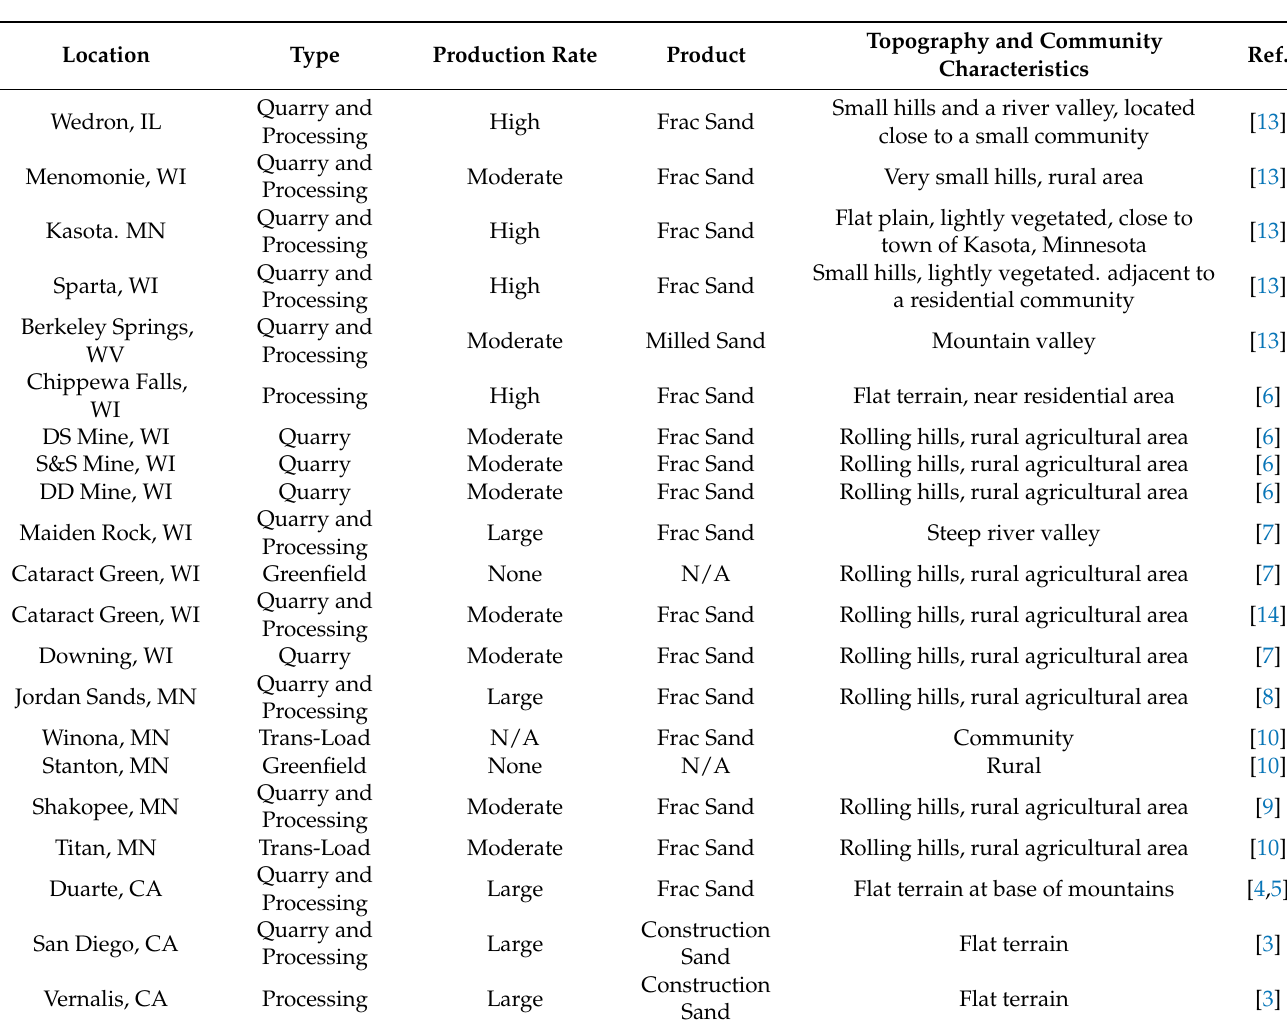
Table 1. Characteristics of the